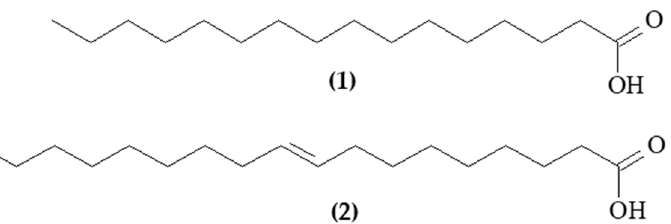
Figure 2. Structural representation of the main components of Hancornia speciosa seed fixed oil. ( 1 ) Palmitic acid and ( 2 ) elaidic acid.